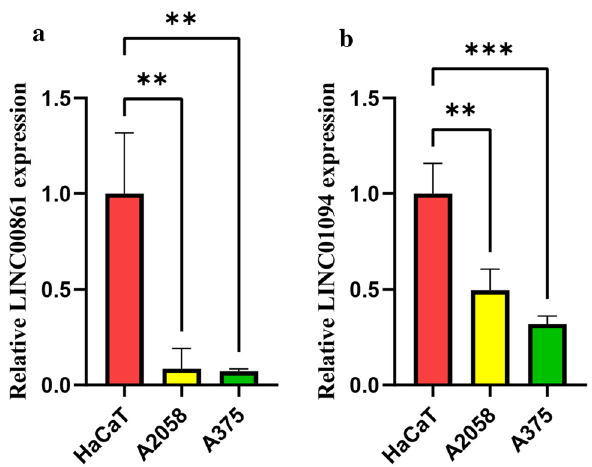
Fig. 8 The differential expres- sion of FRLs was detected by qPCR. a , b Compared with the HaCaT cell line, the FRLs of LINC00861 and LINC01094 were significantly lower in the A2058 and A375 cell lines. *p < 0.05, **p < 0.01, ***p < 0.001, ****p <